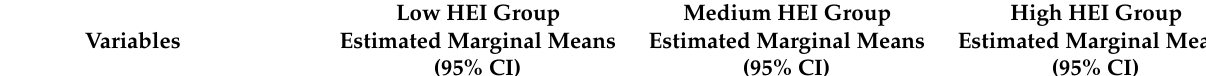
Table 3. Regression-adjusted predicted results for health outcomes by HEI/diet quality